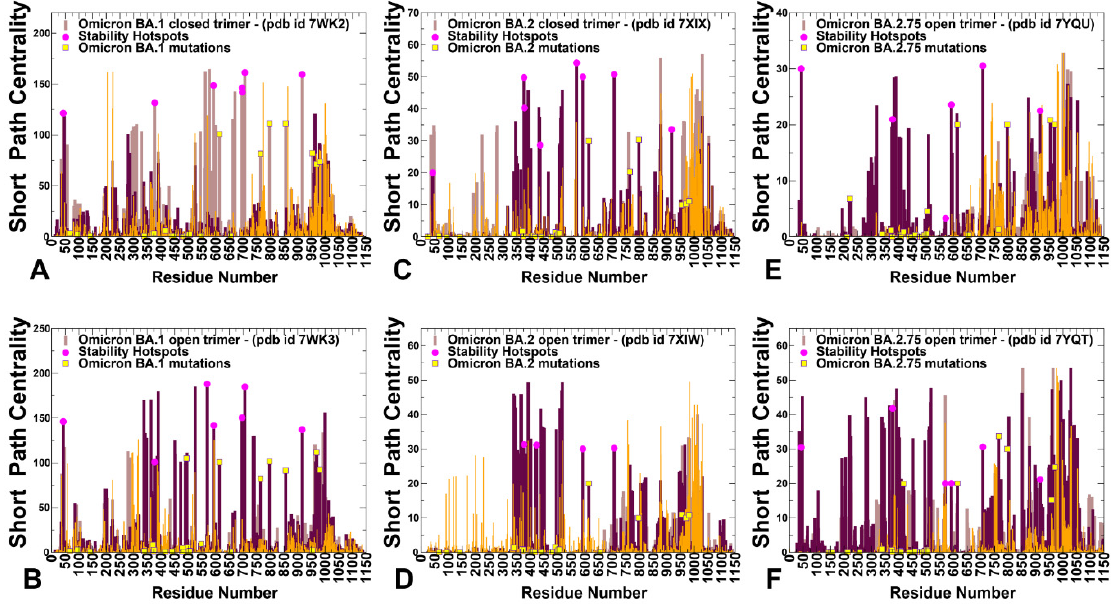
Figure 11. The short path betweenness centrality distributions for the SARS-CoV-2 S Omicron structures. The centrality profiles for the for S BA.1 closed trimer, pdb id 7WK2 ( A ). S BA.1 open trimer, pdb id 7WK3 ( B ). S BA.2 closed trimer, pdb id 7XIX ( C ). S BA.2 open trimer, pdb id 7XIW ( D ). S BA.2.75 closed trimer, pdb id 7YQU ( E ). S BA.2.75 open trimer, pdb id 7YQT ( F ). The profiles are shown in brown, maroon, and orange-colored bars for protomers A, B, and C, respectively. The positions of protein stability hotspots are indicated by magenta-colored filled circles. The positions of the mutational sites for Omicron subvariants are shown in yellow-colored fi lled squares.